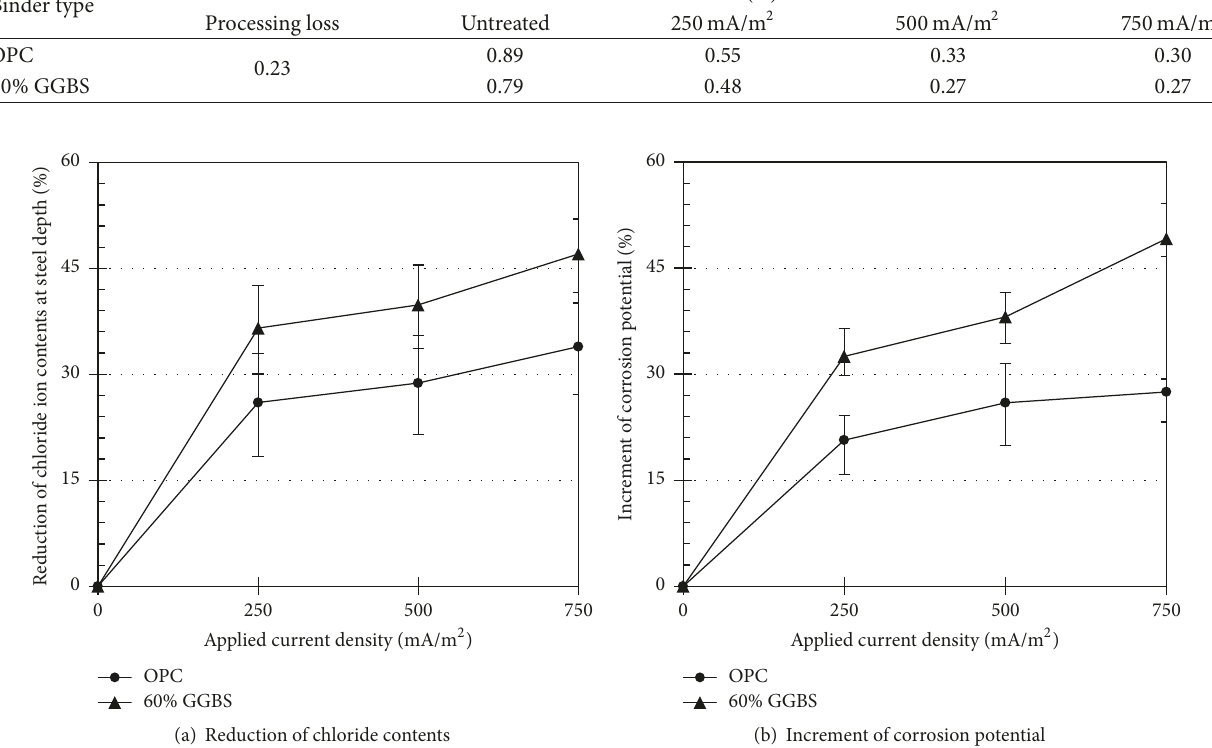
Figure 4: The reduction of chloride contents (a) and increment of corrosion potential (b) according to the applied current densities.